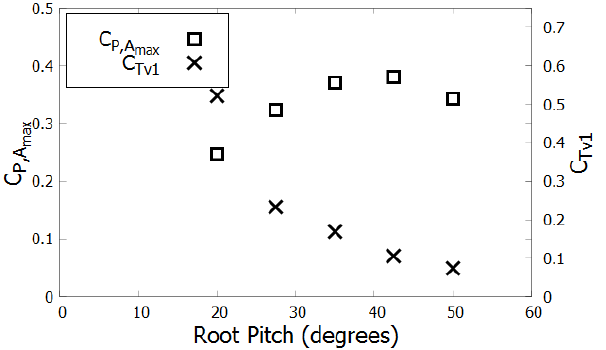
Figure 13. Effect of pitch on C P , A